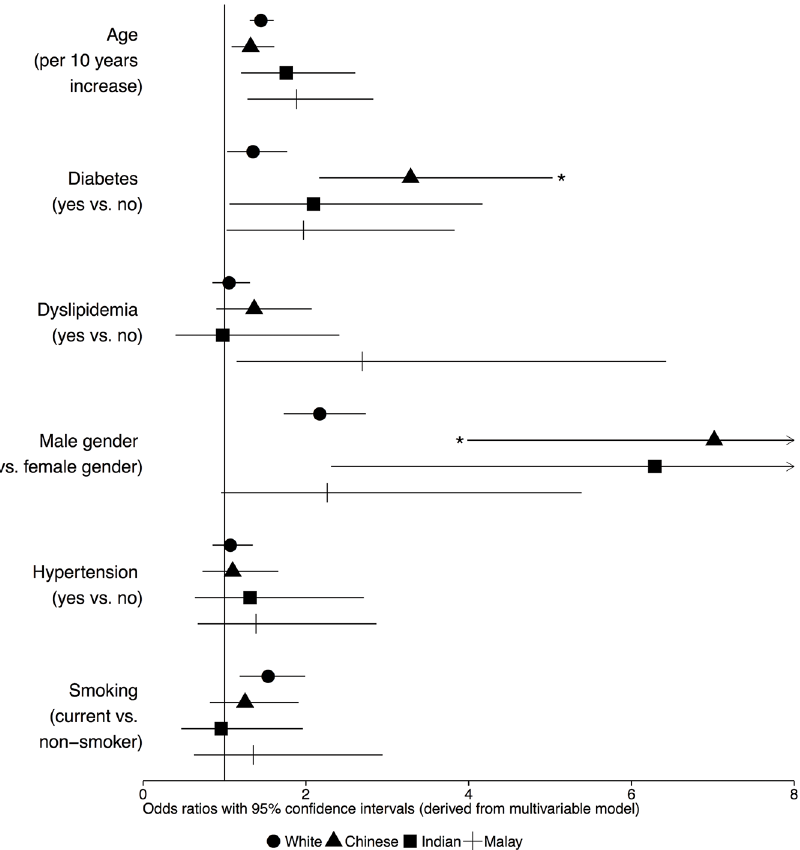
Fig 2. Odds ratios of risk factors for the severity of CAD by ethnicity. Odds ratios derived from multivariable ordinal regression analysis, depicting the strength of association between cardiovascular risk factors and CAD severity (categorized into no CAD, single vessel disease, double vessel disease and triple vessel disease). The point estimates and 95% confidence intervals are shown for each ethnic group. A larger odds ratio indicates a stronger association between the risk factor and CAD severity. The asterisks ( * ) indicate significant interactions (p < 0.05) of the risk factor as compared to Whites.